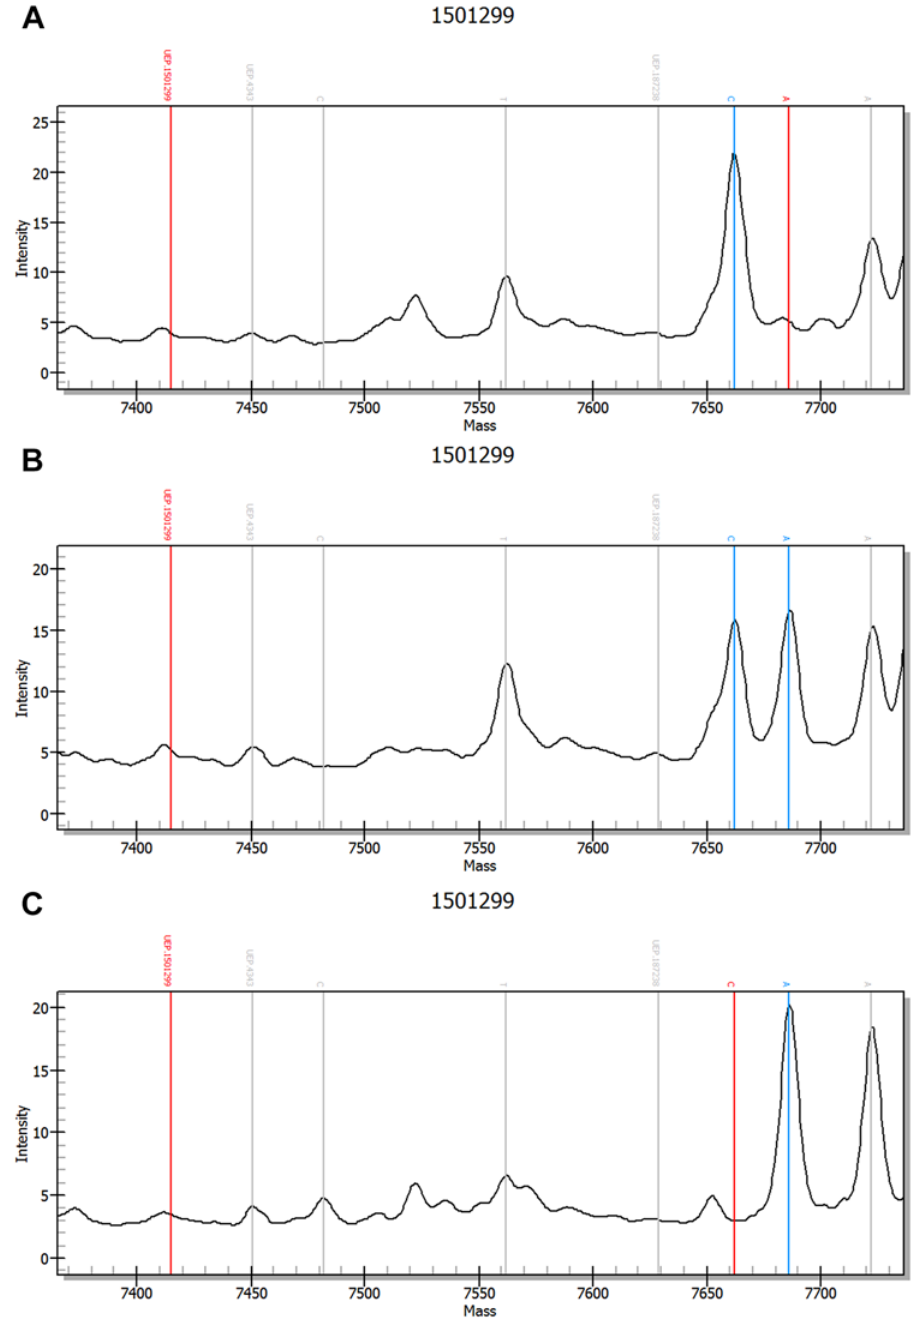
Fig 2. Spectrometric peak chart of rs1501299. (A) ANP gene rs1501299 (G276T) GG genotype. (B) ANP gene rs1501299 (G276T) GT genotype. (C) ANP gene rs1501299 (G276T) TT